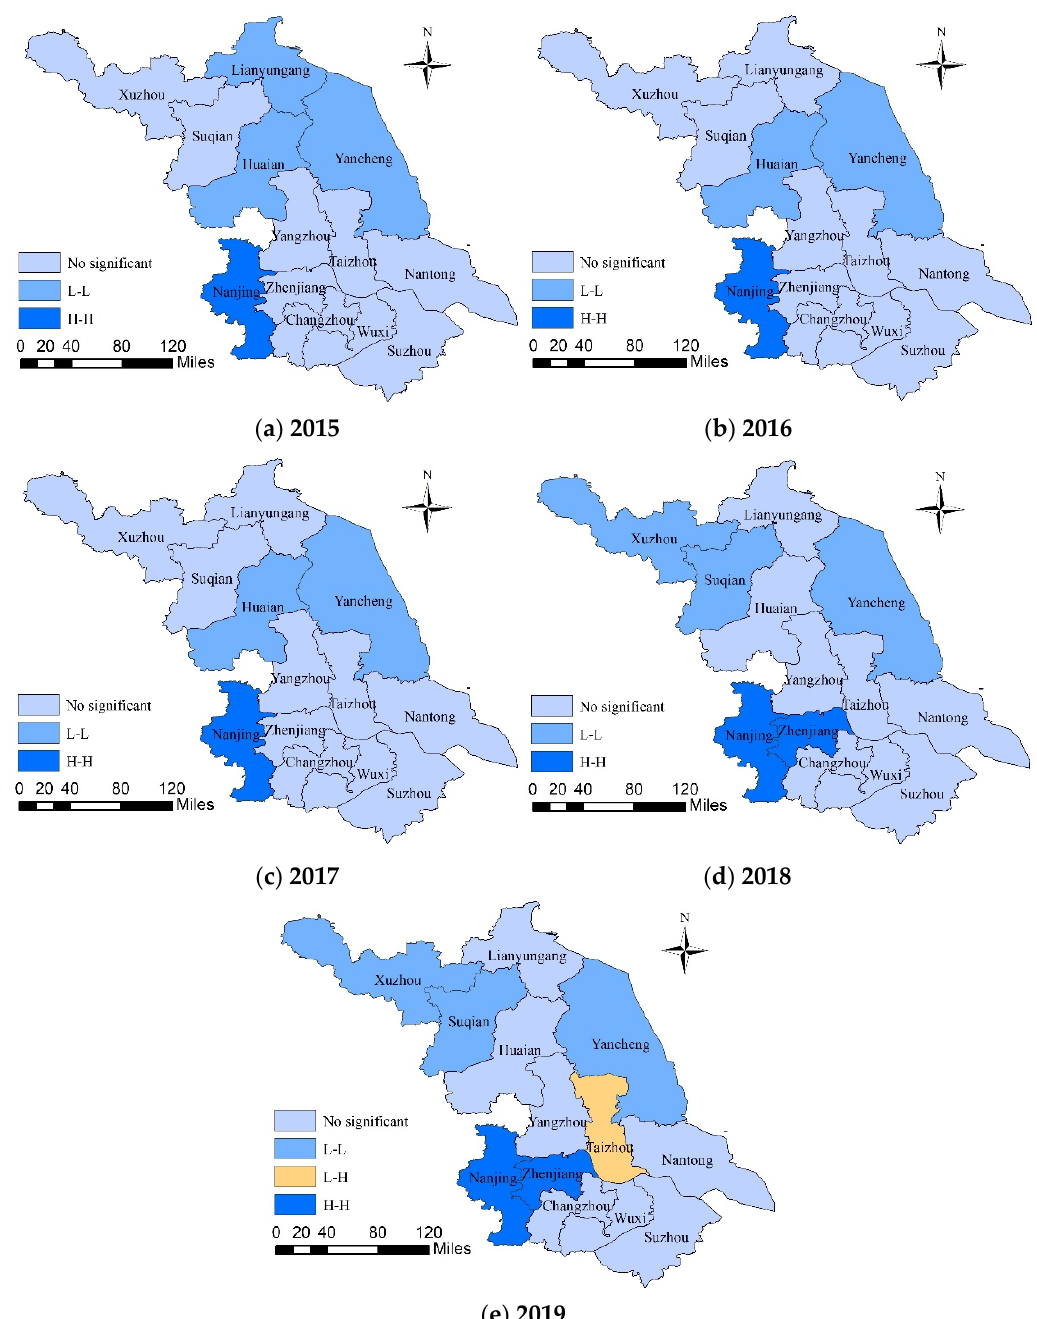
Figure 6. The LISA agglomeration map of the local autocorrelation of medical and health services efficiency in Jiangsu Province from 2015 to 2019.